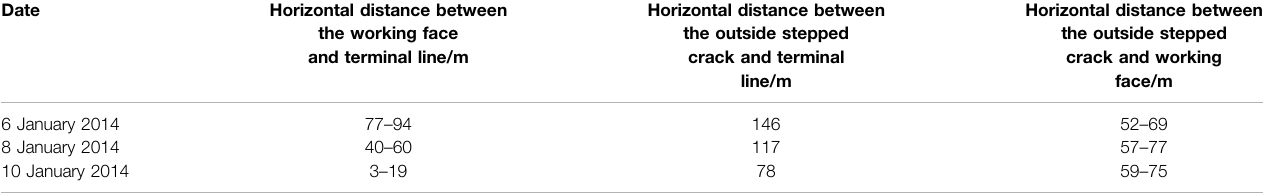
TABLE 5 | Relative position of the stepped crack and the working face.